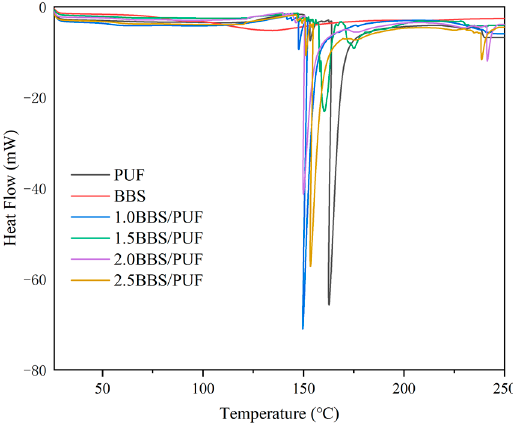
Figure 4. DSC curves of BBS, PUF resin, and BBS ‐ modified PUF resins with different BBS addi ‐ tions.